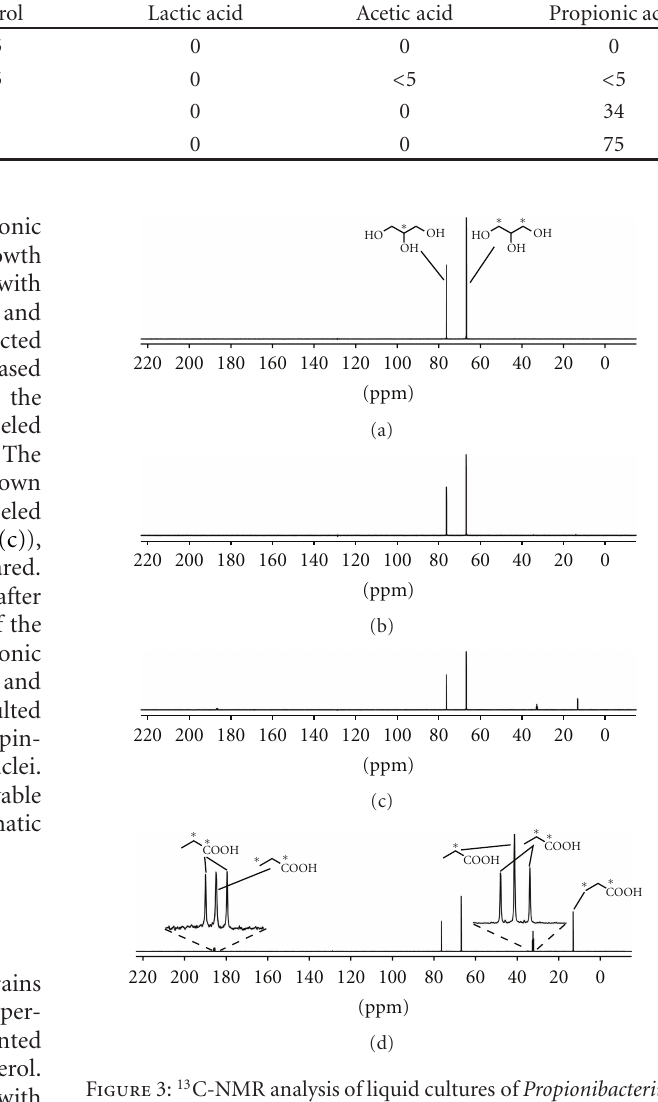
Table 3: Results for bacterial counts, pH, and acids from fermentation of GLY broth prepared with 13 C-labeled glycerol by P. jensenii . Bacterial counts Sampling point cfu/ml (log)